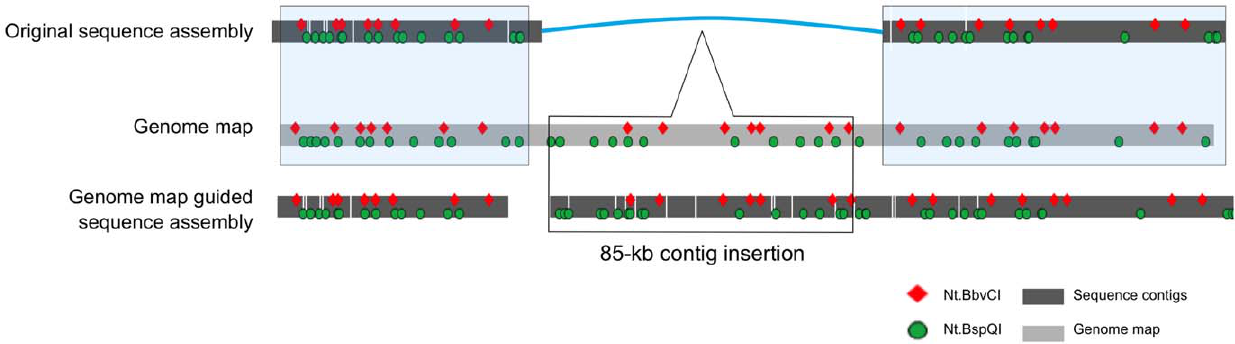
Figure 4. Insertion of unassembled contigs into gaps in genome map-guided denovo sequence assembly. The top line shows the in silico map for the original sequence assembly; the genome map is shown in the middle. An 85-kb segment of DNA was missing from the sequence assembly. The corresponding DNA sequence was added to the assembly by anchoring a previously unplaced scaffold on the genome map. The resulting corrected assembly is shown in the bottom